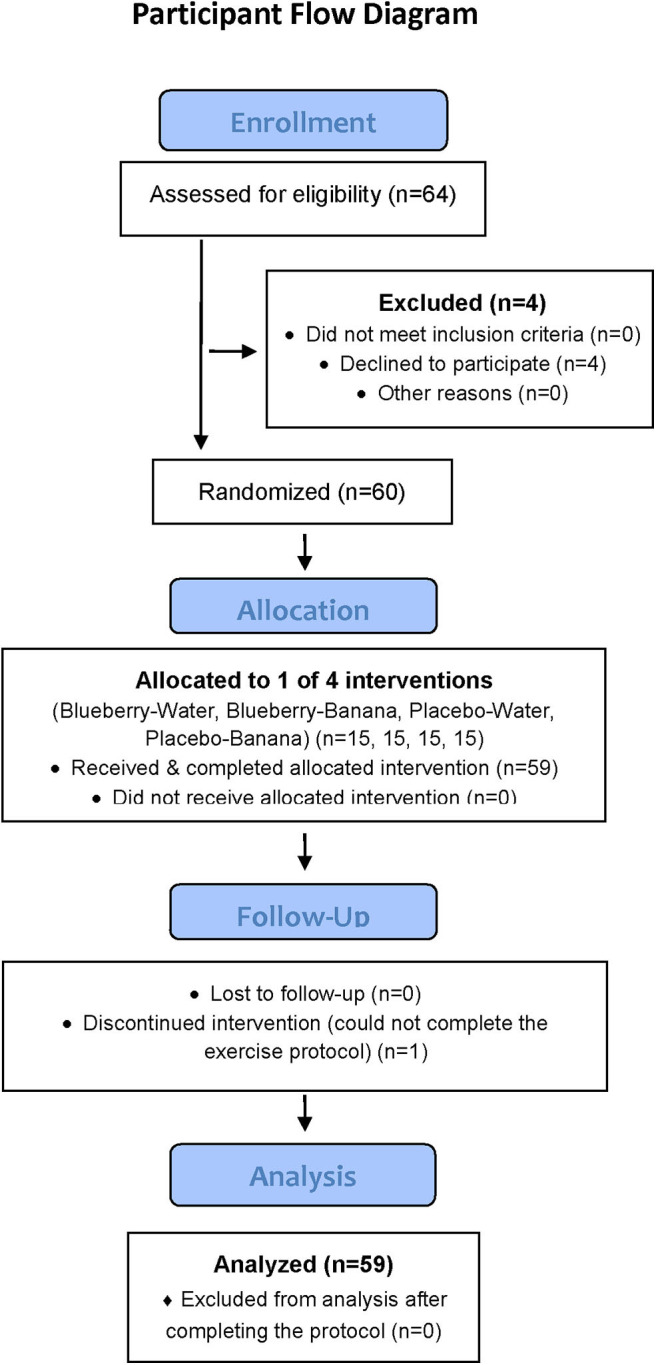
CONSORT participant flow diagram.